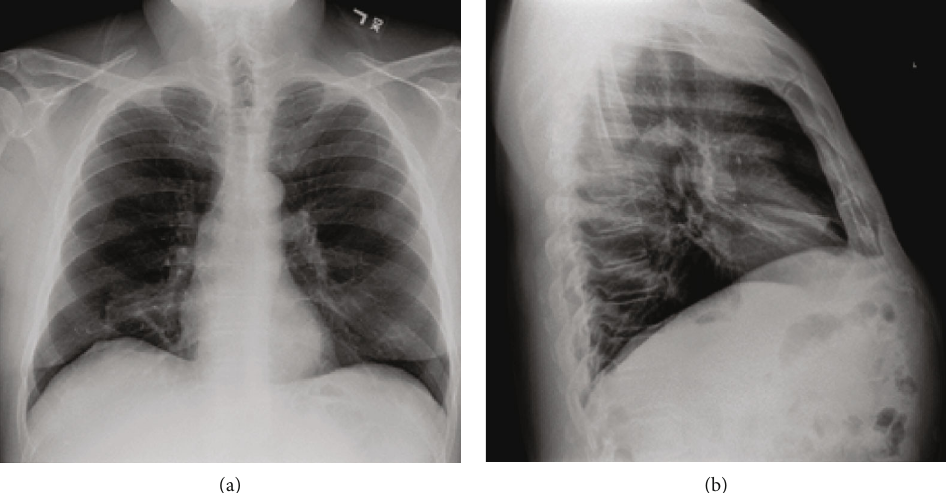
Figure 1: Poster anterior and lateral chest X-ray: right middle lobe in fi ltrate, band-like in shape, overlying the anterior cardiac contour.